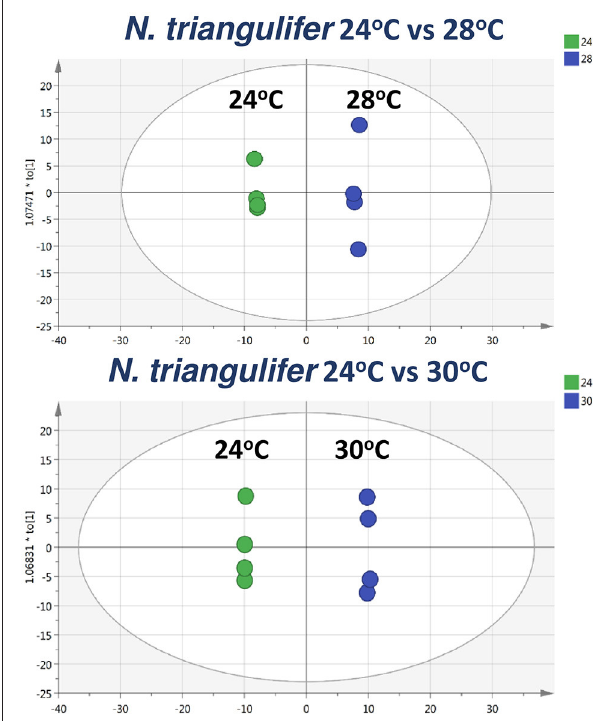
FIGURE 3 | Scores plots of OPLS-DA of larvae reared at 24 vs. 28 ◦ C ( Upper ) and larvae reared at 24 vs. 30 ◦ C ( Lower ). The plots show the differentiating of the heat treated larvae metabolomics profiles from control larvae profiles.